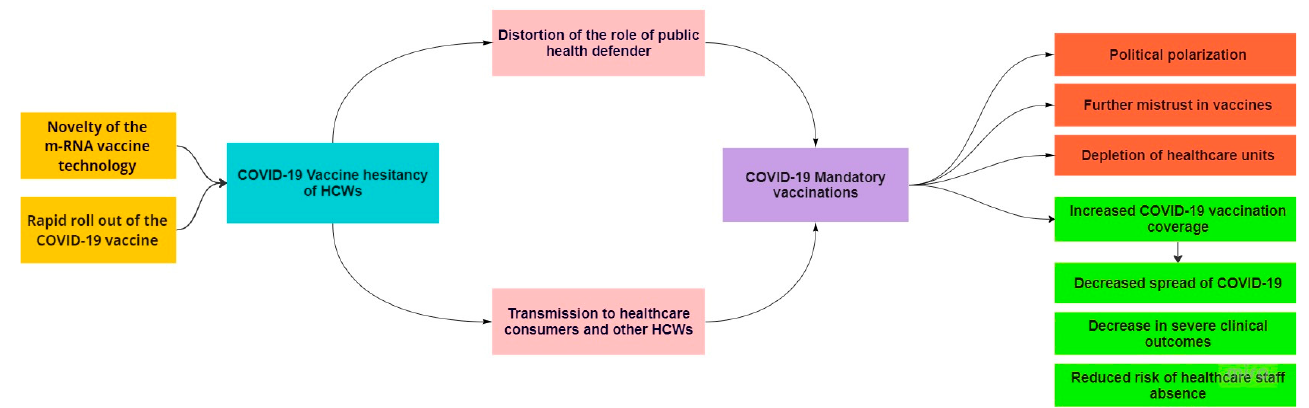
Figure 1. Conceptual framework: HCWs and COVID-19 vaccine mandates.